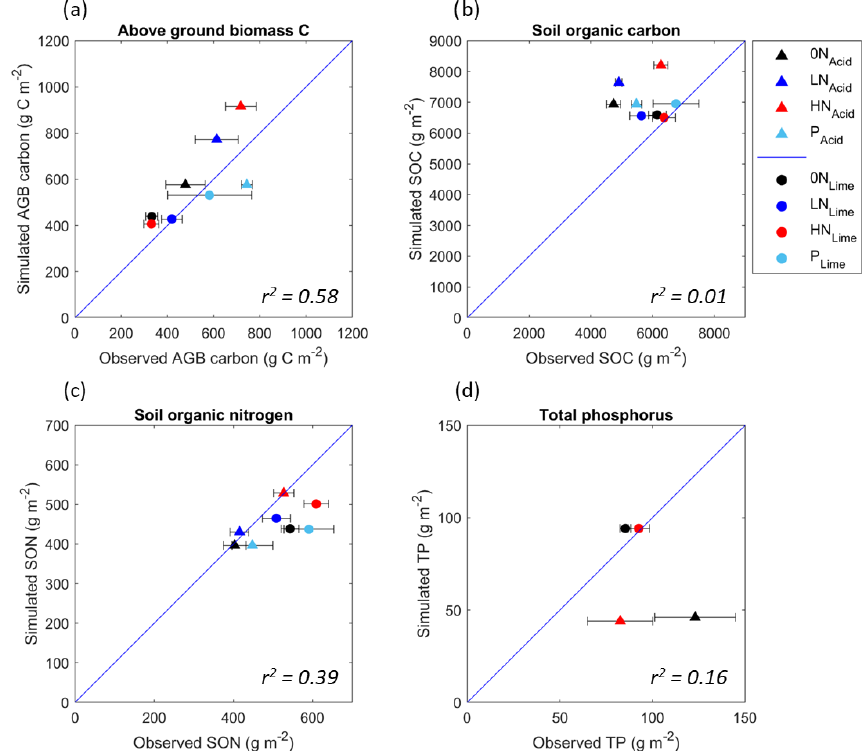
Figure 2. A comparison of the observed values of (a) aboveground biomass carbon, (b) soil organic carbon, (c) soil organic nitrogen, and (d) total soil phosphorus from both grasslands, with simulated values from the model. The blue line represents a 1-to-1 relationship, and the closer the data points are to the line, the smaller the discrepancy between observed and modelled data. All data are in grams per metre squared, and all treatments for which data were collected are presented. The horizontal error bars represent the standard error of the empirical data means. The r 2 value of regression models fitted to the data gives an overall indication of the direction of response of each variable to nutrient addition; hence a low value is not necessarily indicative of poor model